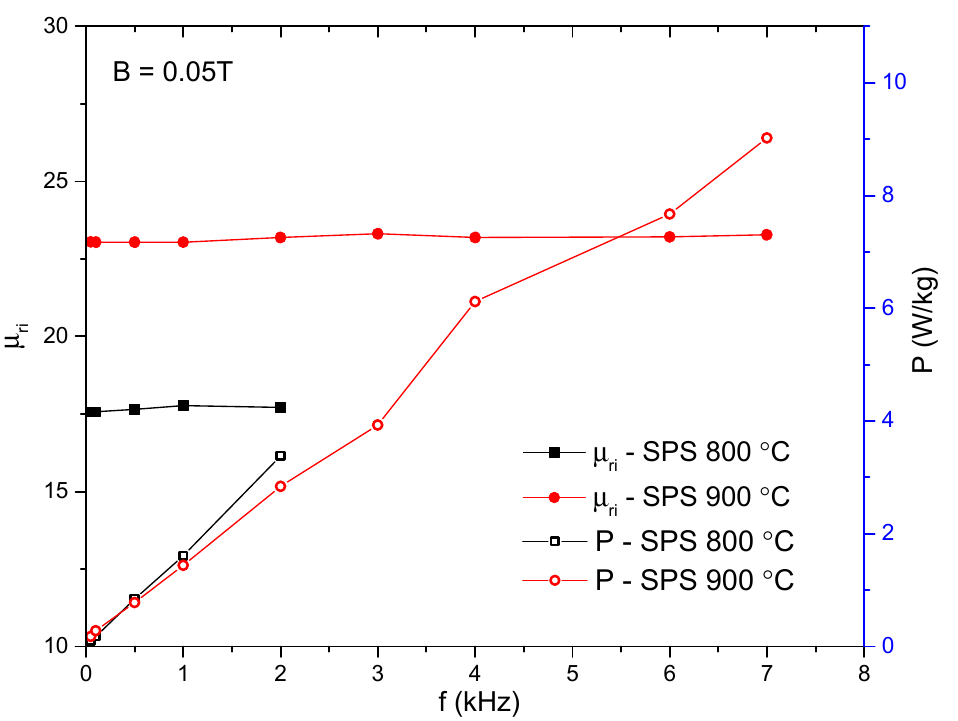
Figure 8. Evolution of magnetic losses and initial magnetic permeability as a function of frequency for toroidal-shaped sintered compacts.